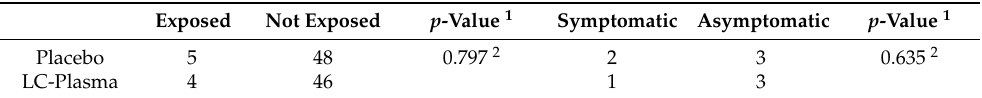
Table 2. Exposure rate to DENV between groups.